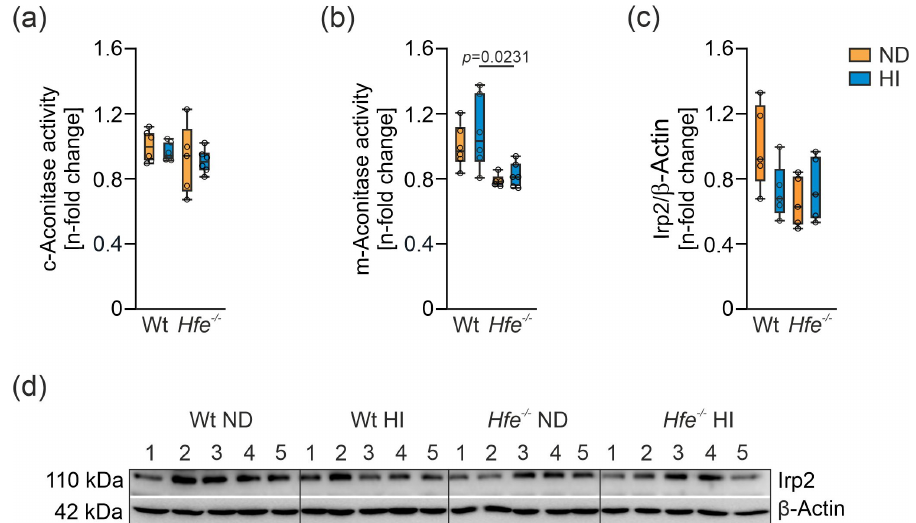
Figure 3. Functional effect of dietary and genetic iron overload on iron metabolism. ( a ) Cytosolic aconitase (c-aconitase) and ( b ) mitochondrial aconitase (m-aconitase) activity in Hfe − / − mice on ND and HI. ( c ) and ( d ), densitometric quantification and Western blot of iron regulatory protein 2 (Irp2) protein. β -Actin served as loading control. Values are depicted as n-fold change of Wt ND. All results were obtained from snap-frozen samples. n = 5–6 mice per group. Two-way ANOVA: ( a ) diet, F (1,19) = 0.2176, p = 0.6462; genotype, F (1,19) = 1.813, p = 0.1940; diet X genotype, F (1,19) = 0.05023, p = 0.8251; ( b ) diet, F (1,19) = 0.9945, p = 0.3312; genotype, F (1,19) = 15.89, p = 0.0008; diet X gen- otype, F (1,19) = 0.1675, p = 0.6869; ( c ) diet, F (1,16) = 1.291, p = 0.2726; genotype, F (1,16) = 3.135, p = 0.0957; diet X genotype, F (1,16) = 4.116, p = 0.0595. Values are shown as median ± interquartile range. The exact p -values are indicated in the graphs.